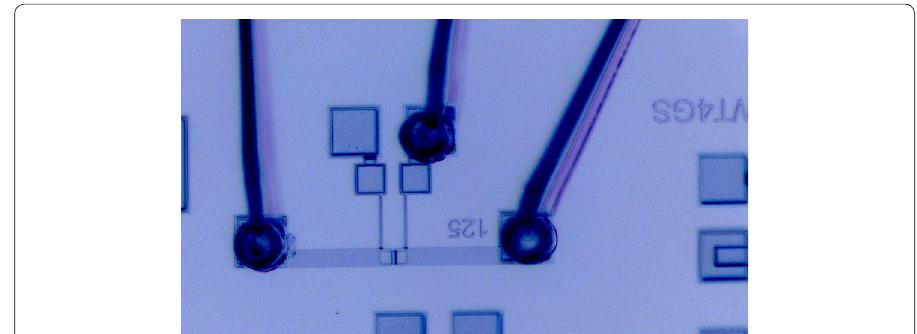
Fig. 5 The actuator under the microscope of the probe station